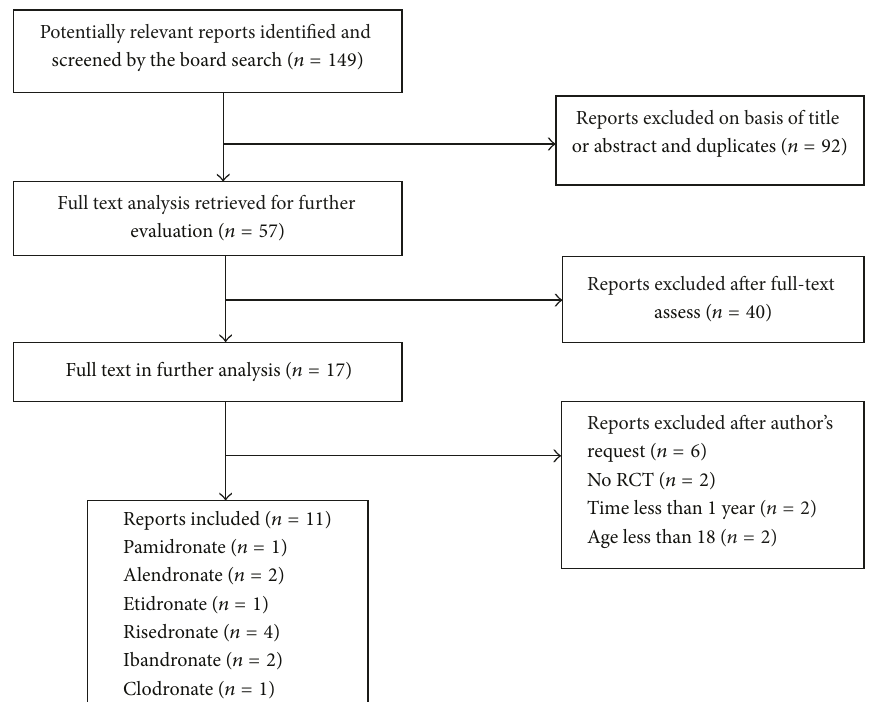
Figure 1: Flowchart of study selection in the